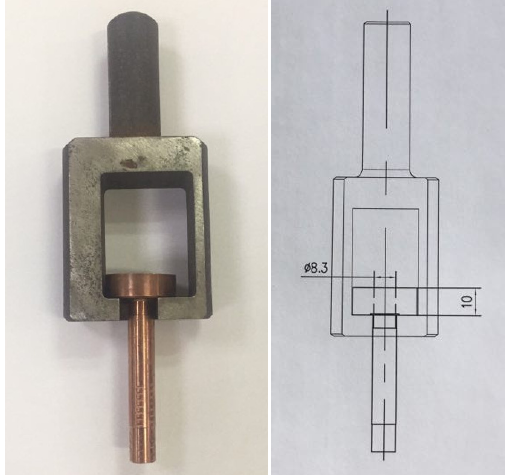
Figure 3. Photo and schematic diagram of the setup for the tensile shear test.